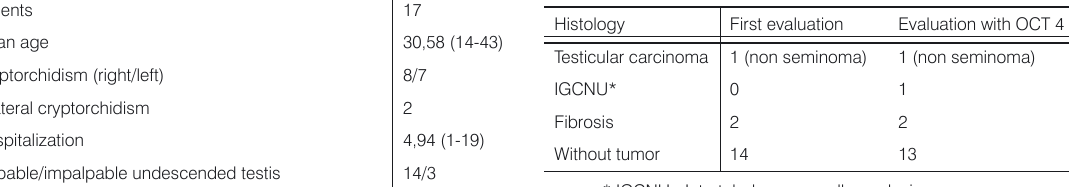
Table 2. Summary of histology results with and without OCT 4 immunostaining.